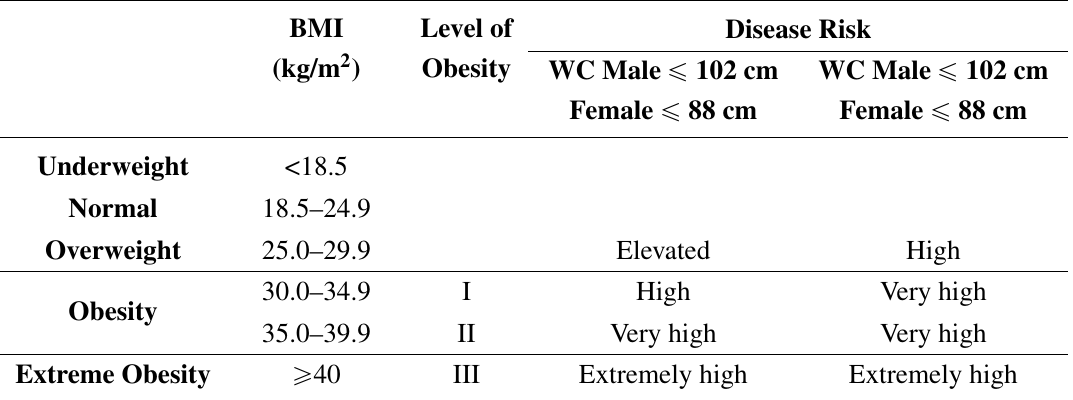
Table 2. BMI, WC, and Diabetes Risk for Brazilians Patients.